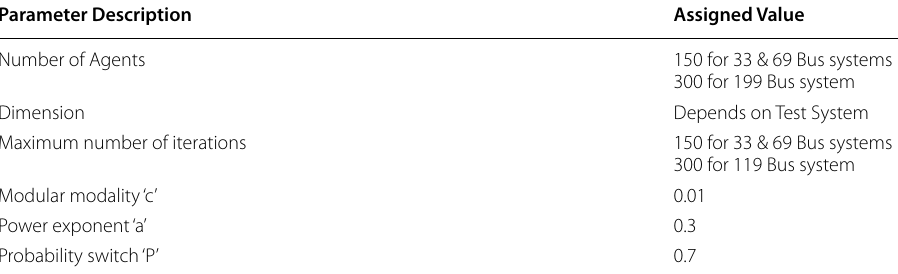
Table 2 BO algorithm